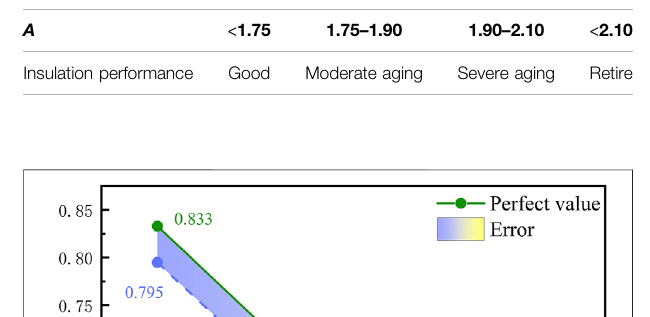
TABLE 6 | Non-uniform thermal aging condition evaluation.